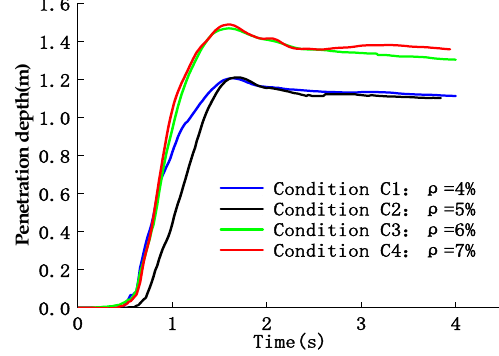
Figure 25. Bow impact depth time-history curve.